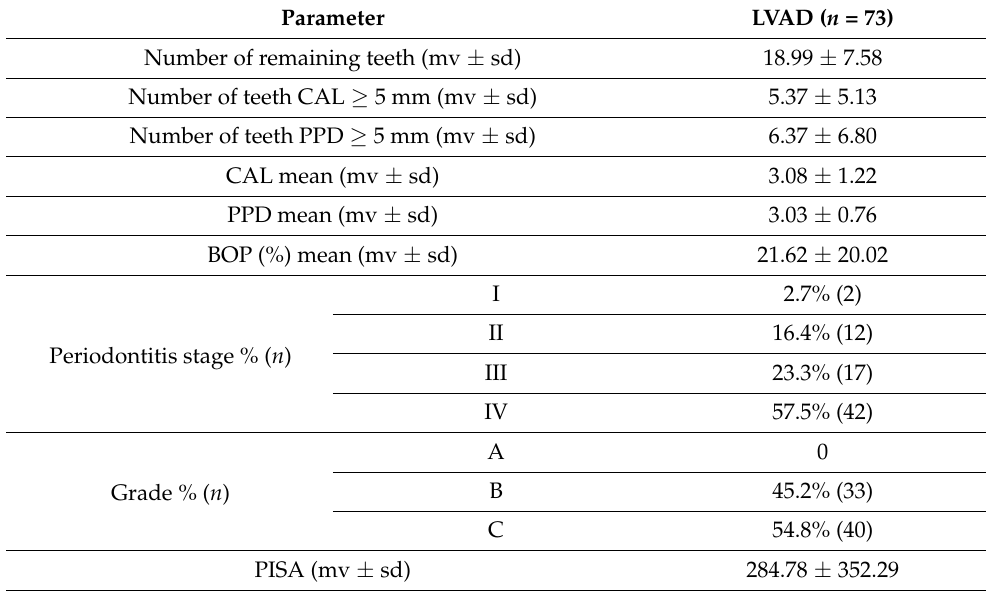
Table 3. Oral health conditions of included LVAD